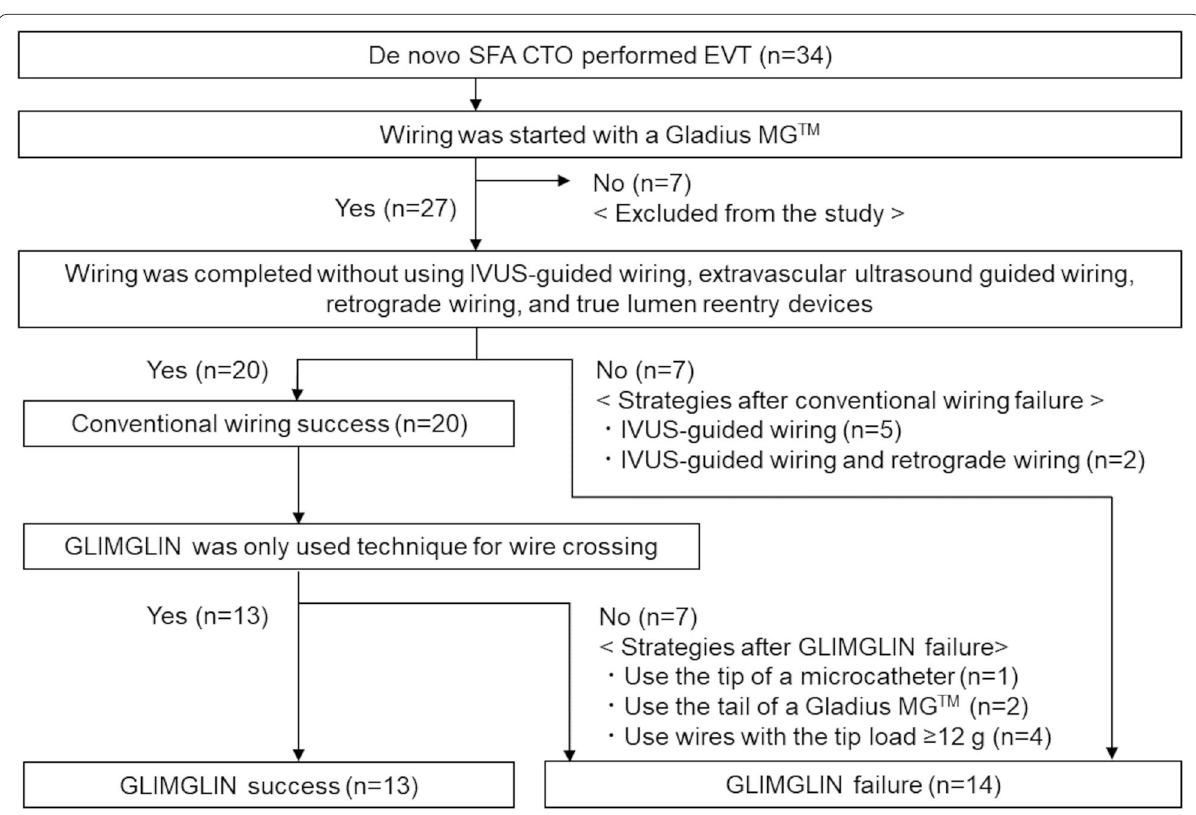
Fig. 2 The study flowchart. During the study, the 34 symptomatic PAD patients with de novo SFA CTO performed EVT, and the 27 patients were included to the study. In those, conventional wiring and GLIMGLIN were succeeded in 20 and 13 patients,